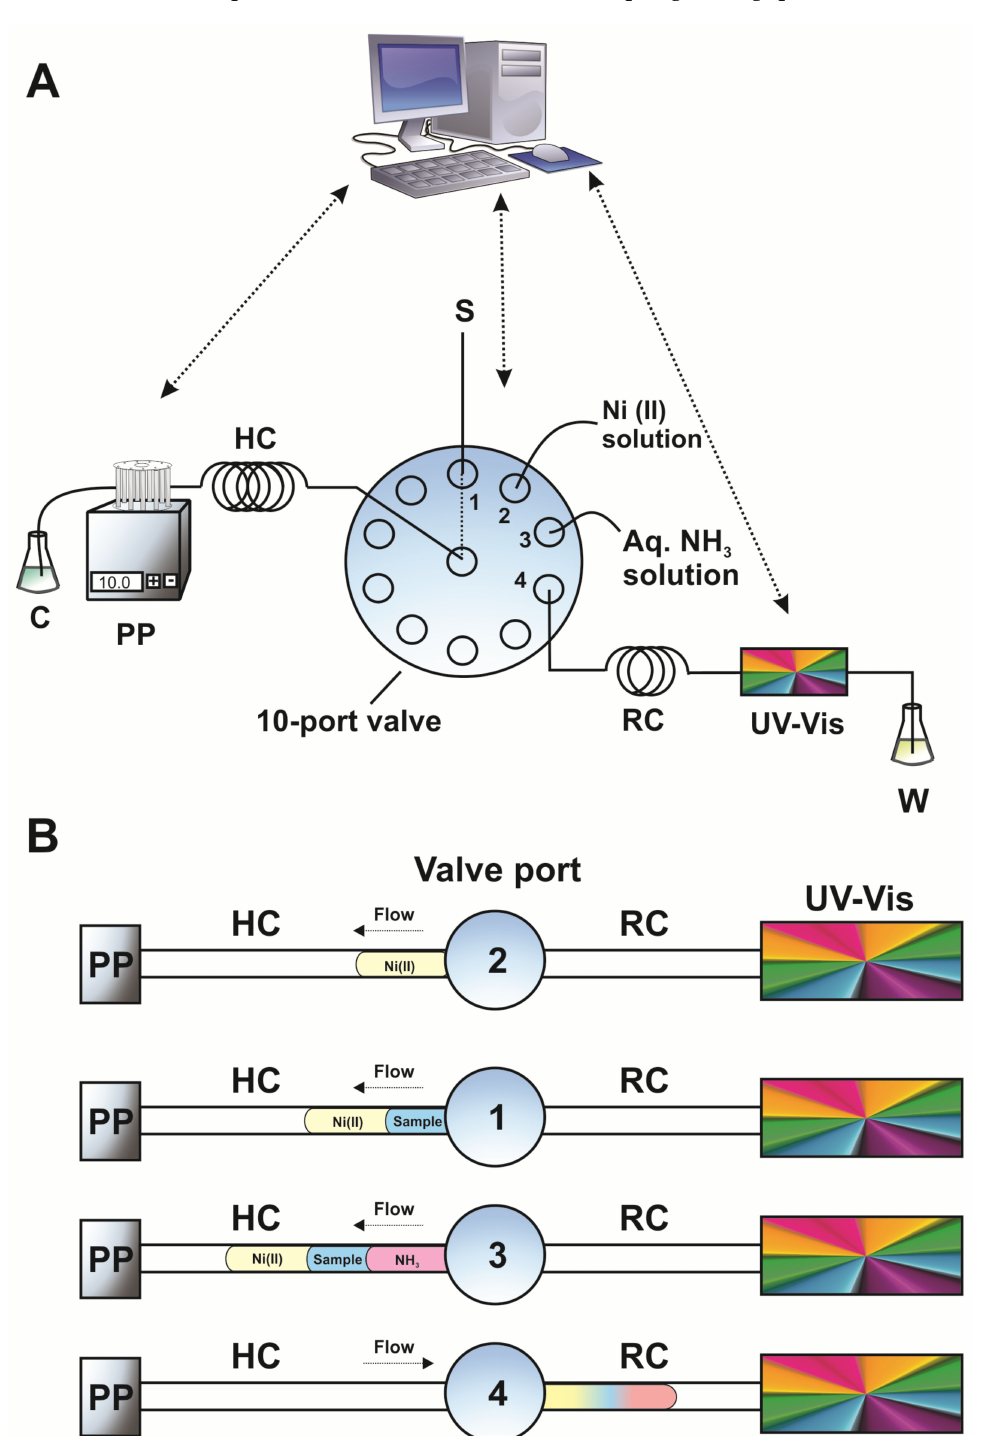
Figure 5. ( A ) Graphical depiction of the zone fluidics manifold and ( B ) the analytical sequence steps for the analysis of CAP; PP = peristaltic pump, HC = holding coil, S = sample, UV-Vis = spectrophotometric detector, RC = reaction coil, C = carrier (water), W =